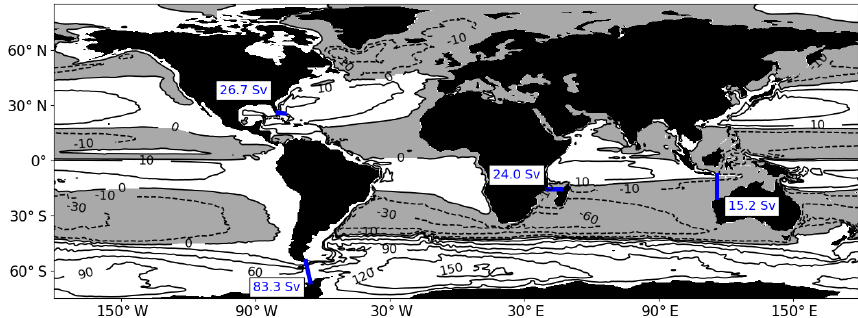
Figure 10. Time-mean barotropic stream function (in Sverdrup, Sv) derived from the last 500 years of the FOCI-piCtl simulation. White/grey shading indicates clockwise/counterclockwise rotation. The black lines represent the contours for 10Sv as well as in 30Sv intervals up to 150Sv. The blue lines indicate selected transport sections (see Fig. 11) with mean transport values in the box